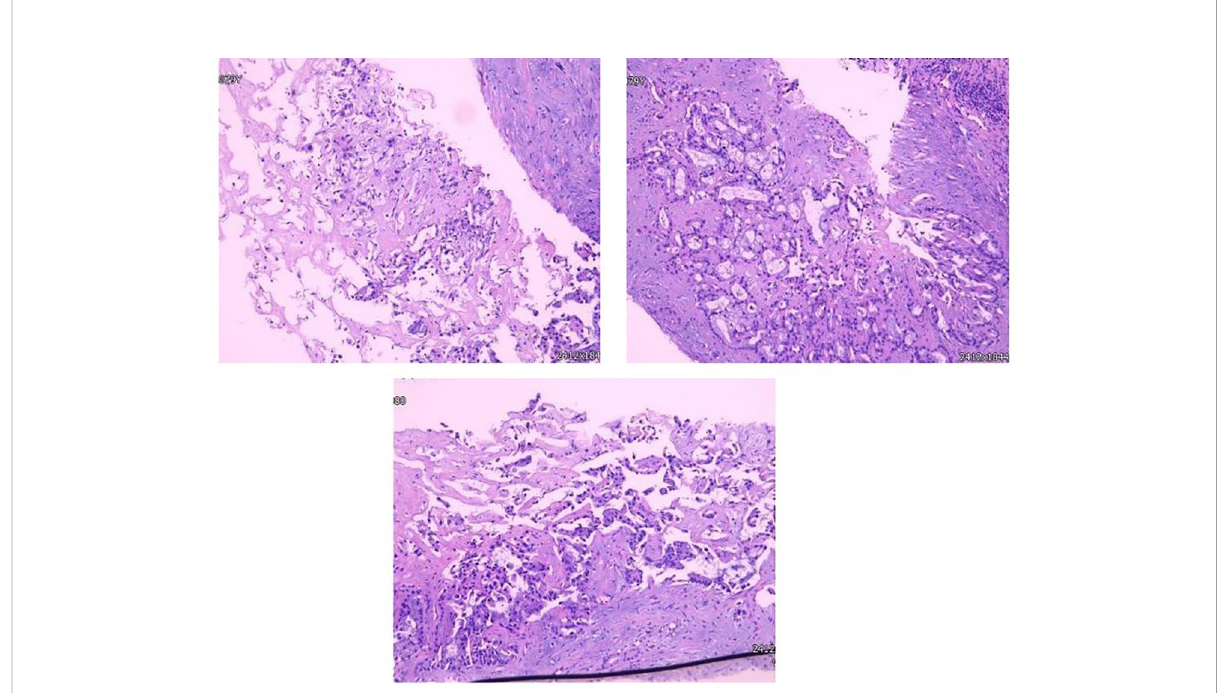
FIGURE 3 Glandular formations of varied size, shape, and irregular arrangement that have invaded the